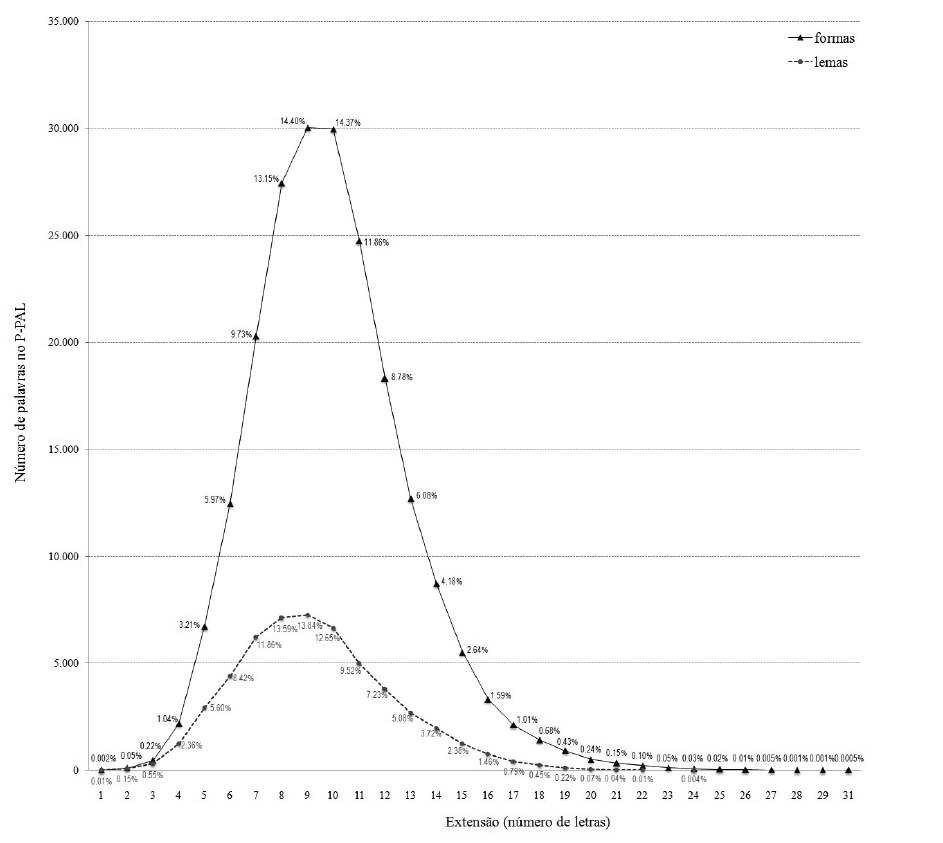
Figura 2 . Distribuição das 208.642 formas e 52.404 lemas do P-PAL por extensão de palavra (número de letras).